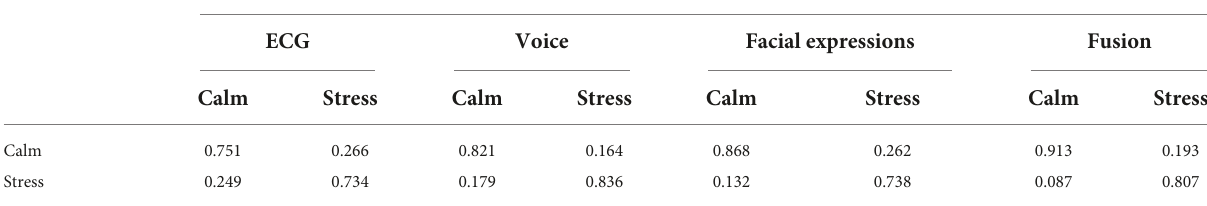
TABLE 2 Stress detection confusion matrix of the single-modal and multimodality methods.